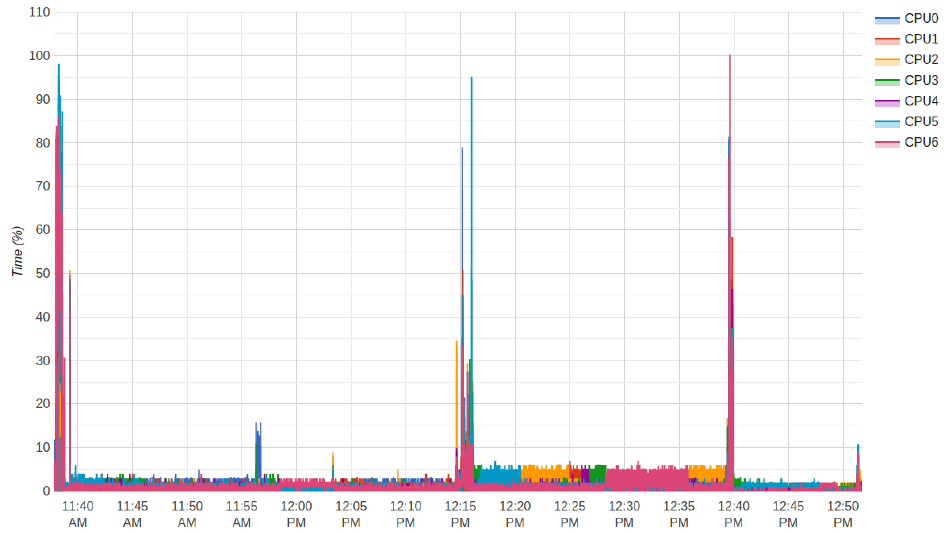
Figure 5. CPU usage of EmuCD running BitTorrent on 100 nodes, 50 MB